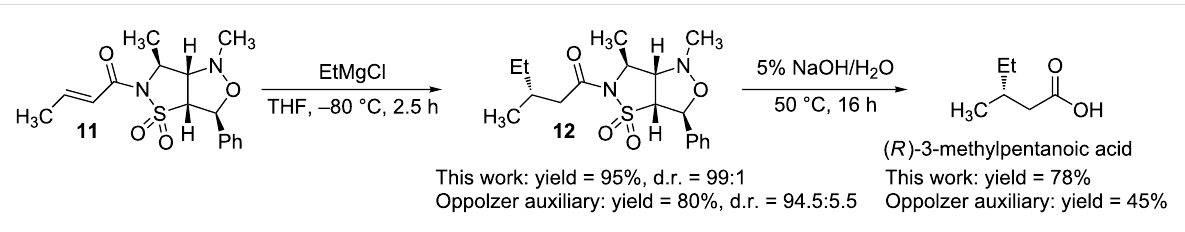
Scheme 3: Comparison between auxiliary 5 and the Oppolzer auxiliary in a DCA reaction.